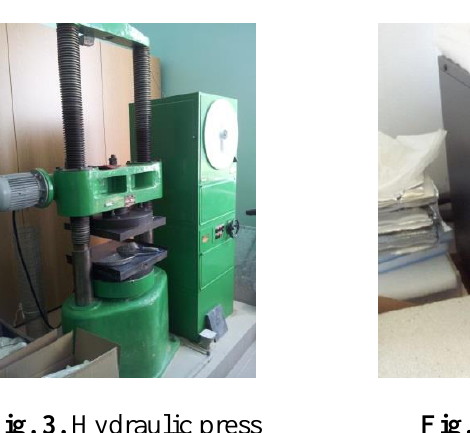
Fig. 3. Hydraulic press ЗИМ П-125.